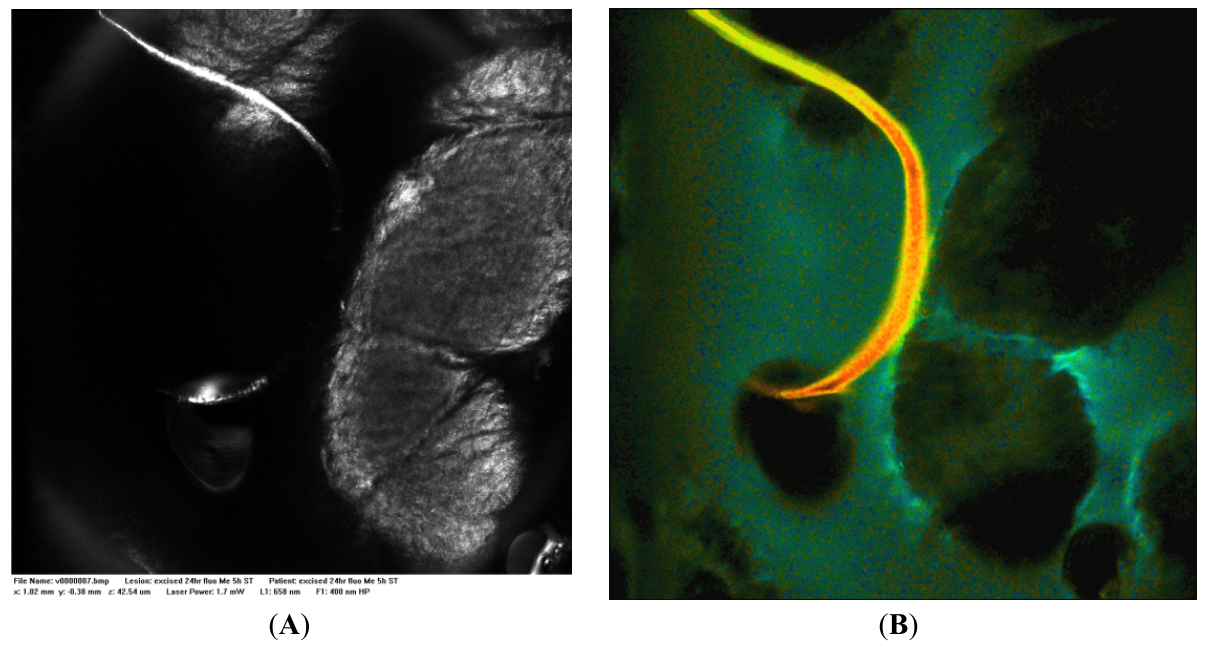
Figure 4. ( A ) Vivascope 658 nm reflectance image and ( B ) 488 nm FLIM image acquired 40 µm below the skin surface 5 h after application of fluorescein in microemulsion at 16 mg/mL, magnification 400×; Field of view: 500 micron × 500 micron, FLIM color